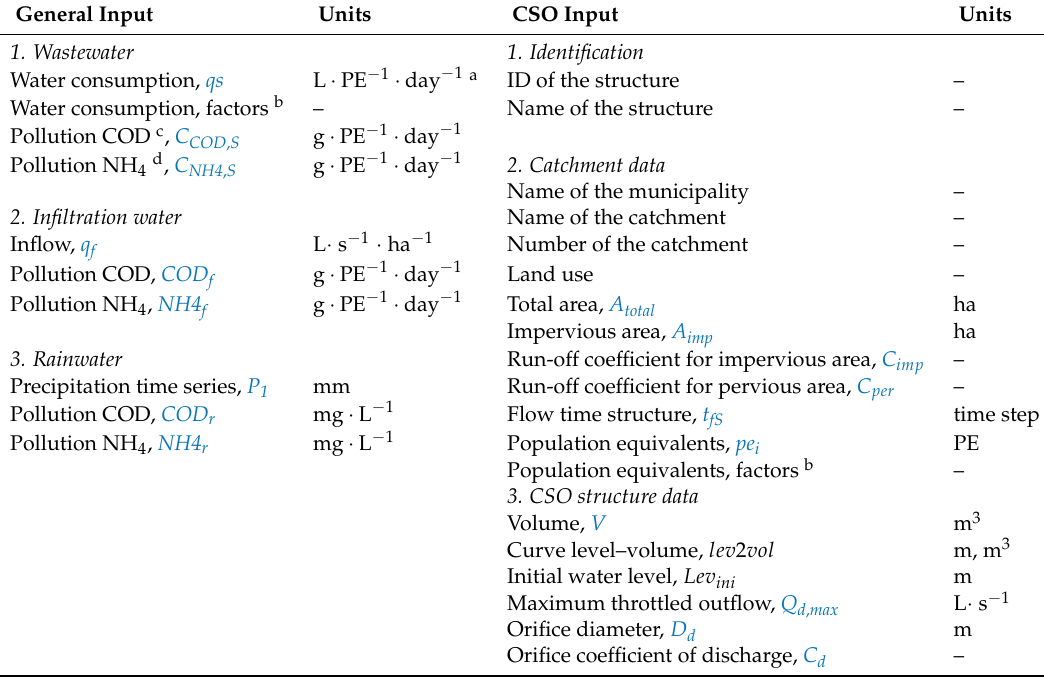
Table 1. General and combined sewer overflow (CSO) structure input data of